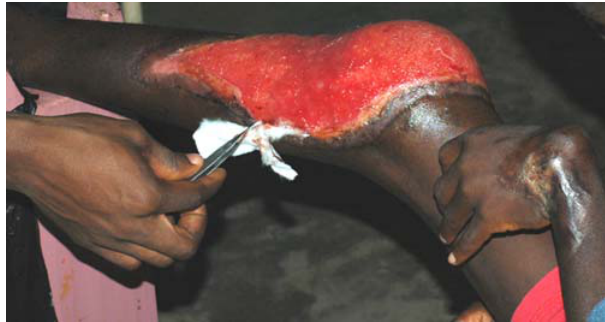
Figure 1. Buruli ulcer on the left limb following surgical debridement. Also shown is joint contracture of the left wrist from scarring caused by Buruli ulcer.